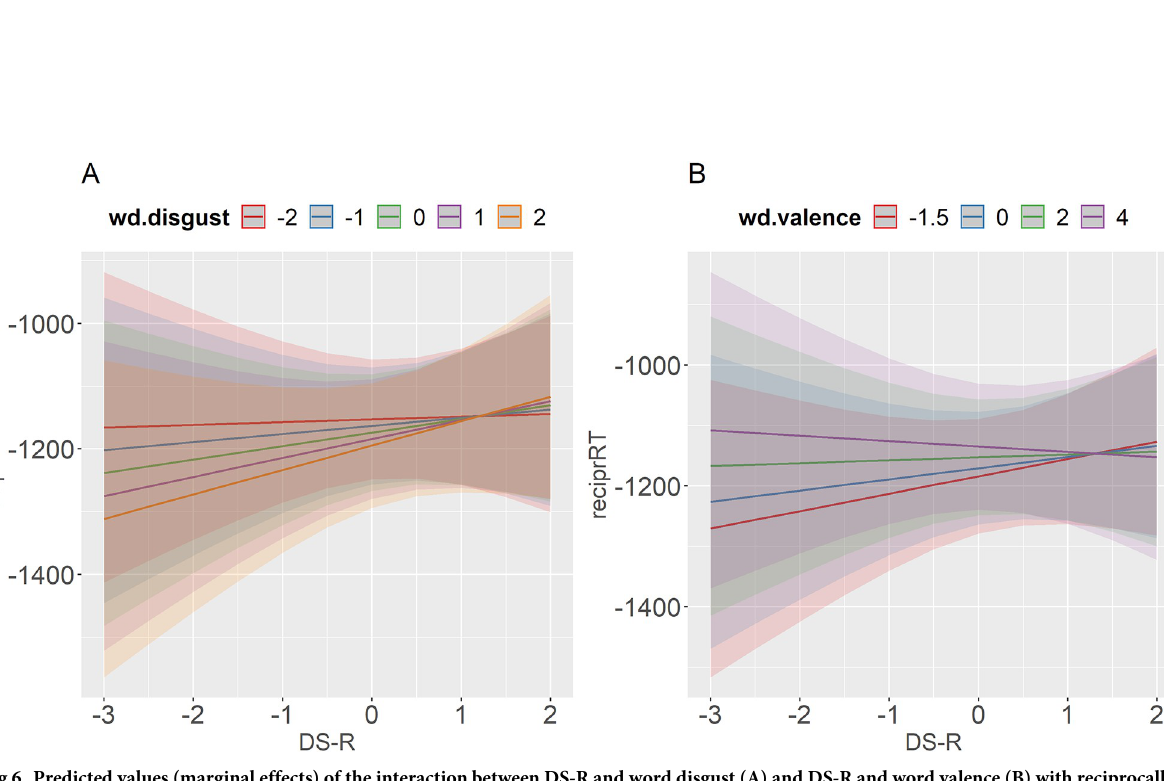
PLOS ONE | https://doi.org/10.1371/journal.pone.0271206 July 21, 2022 15 /